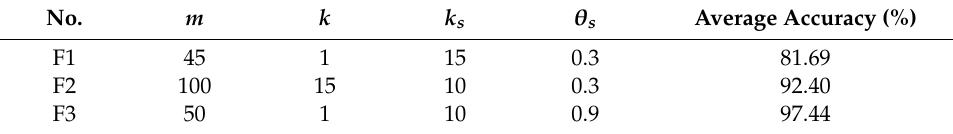
Table 11. Optimum parameters of the DNM + biogeography-based optimization (BBO).